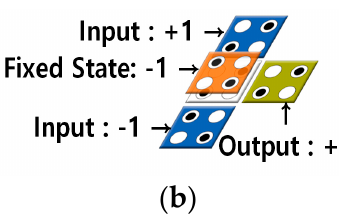
Figure 3. Signal transmission in multi-layer: ( a ) Grid expression of vertical transmission; ( b ) Grid